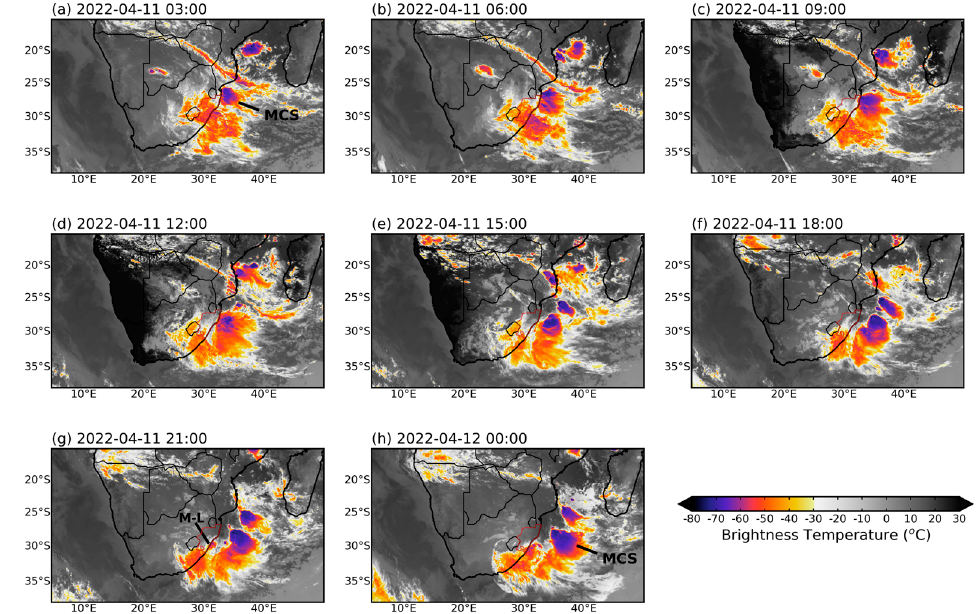
Figure 4. Brightness temperature (shaded; °C) taken from EUMETSAT Meteosat infrared satellite data at 3 h intervals (from left-hand side to right-hand side) starting at ( a ) 0300 UTC 11 April 2022 (top left-hand side) through to ( h ) 0000 UTC 12 February (bottom centre). The location of the MCS discussed in the text is highlighted in panel ( a ), while the location of the meso-low is show in panel ( g ).